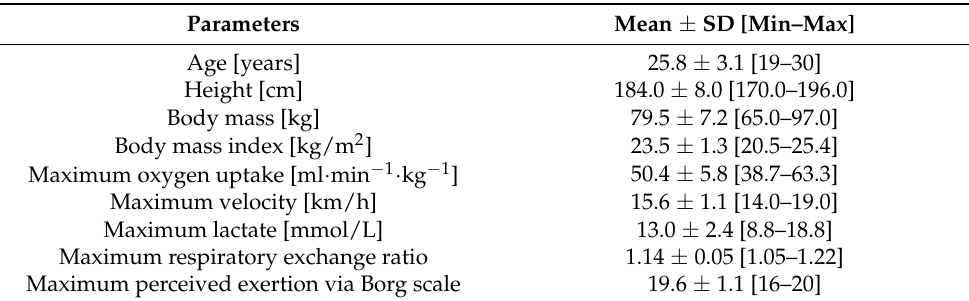
Table 1. Basic and spiroergometry related properties of the participants 1